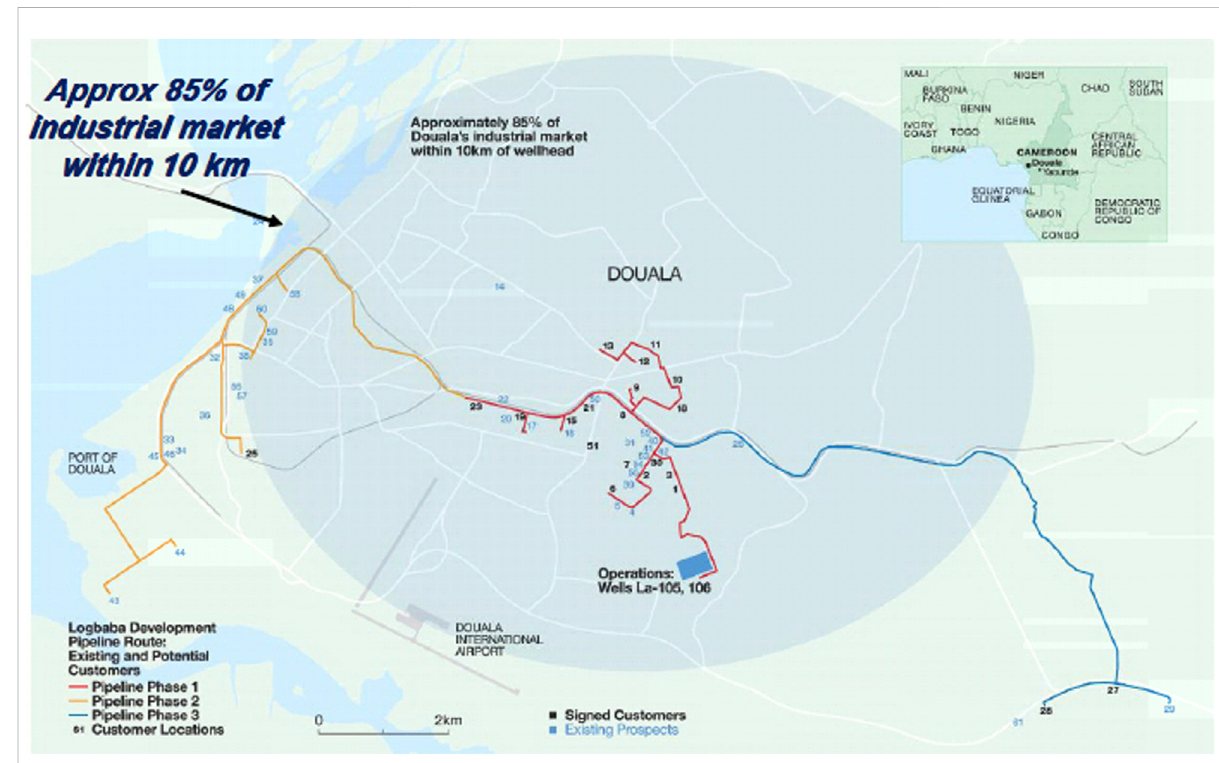
FIGURE 1 View of the study area and gas pipe from the gas company wellhead to customers (Victoria Oil & Gas, 2018).